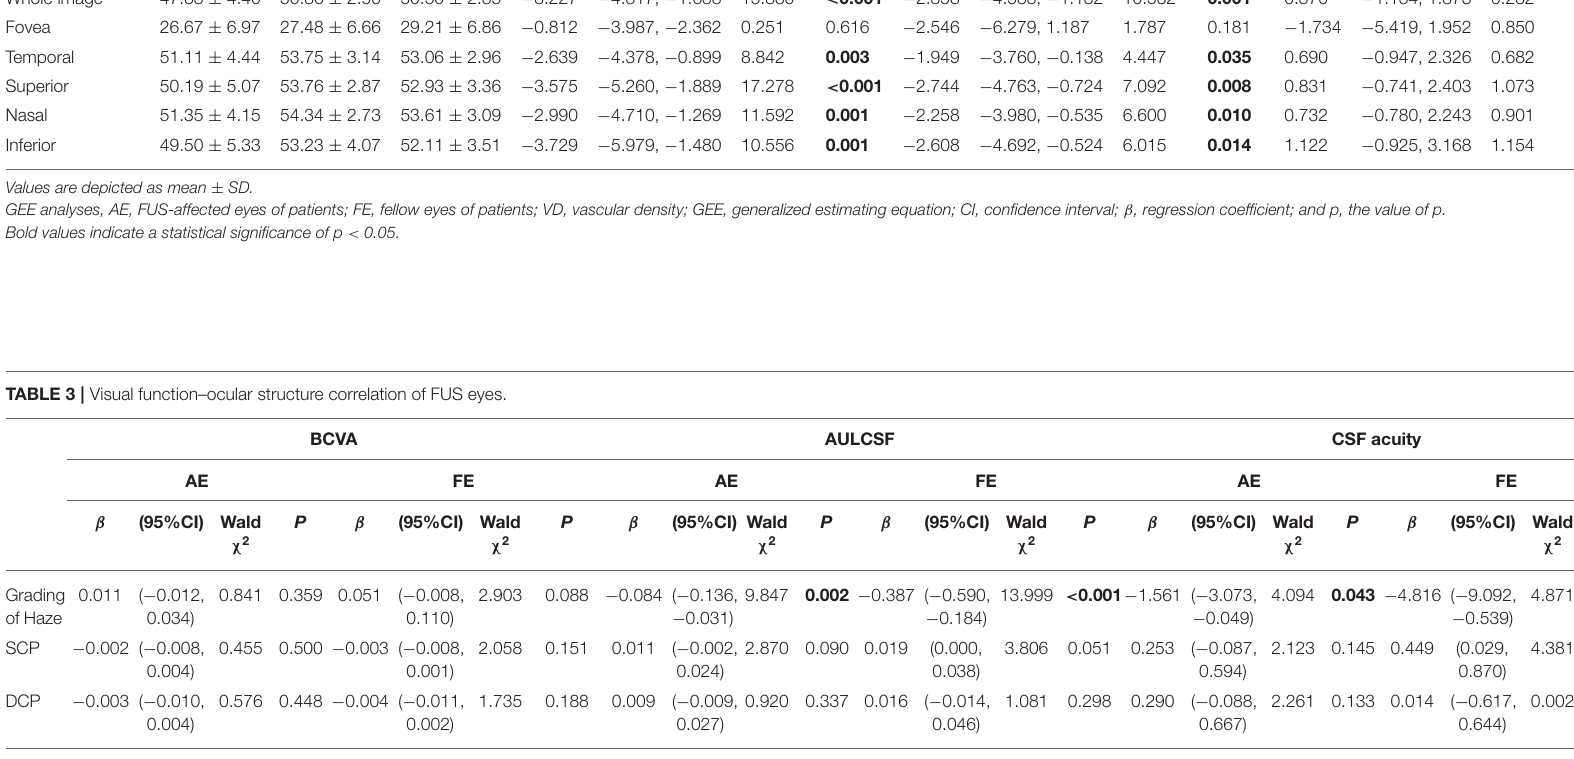
GEE analyses, AE, FUS-affected eyes of patients; FE, fellow eyes of patients; SCP, superficial capillary plexus; DCP, deep capillary plexus. GEE, generalized estimating equation; CI, confidence interval; β , regression coefficient; and p, the value of p. Bold values indicate a statistical significance of p <